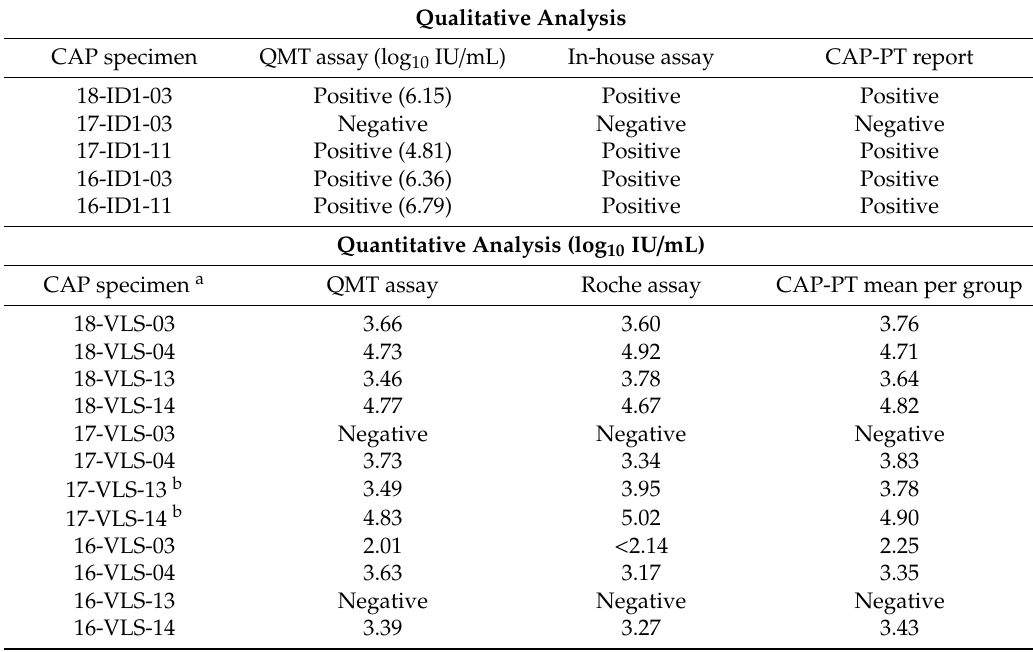
Table 3. Accuracy of the QMT assay as determined using College of American Pathologists Proficiency Testing (CAP-PT) specimens as external quality control specimens for qualitative and quantitative